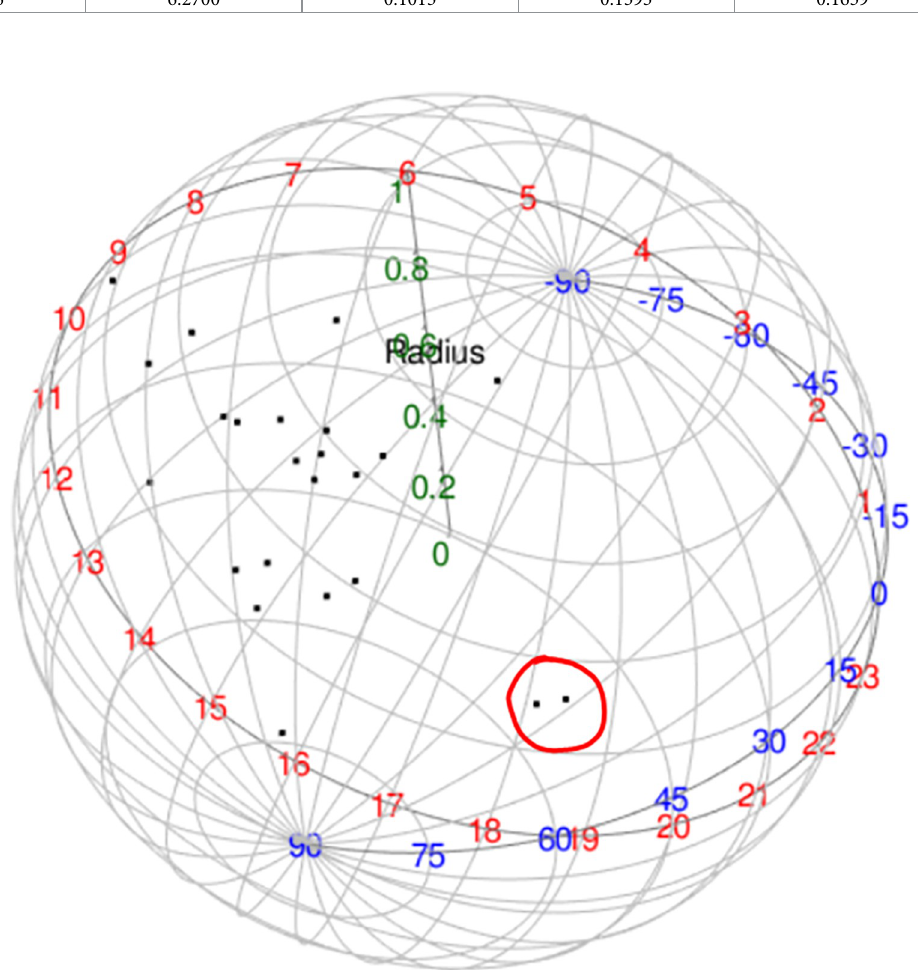
Fig 7. Spherical plot of eye data (a patch of two outliers).